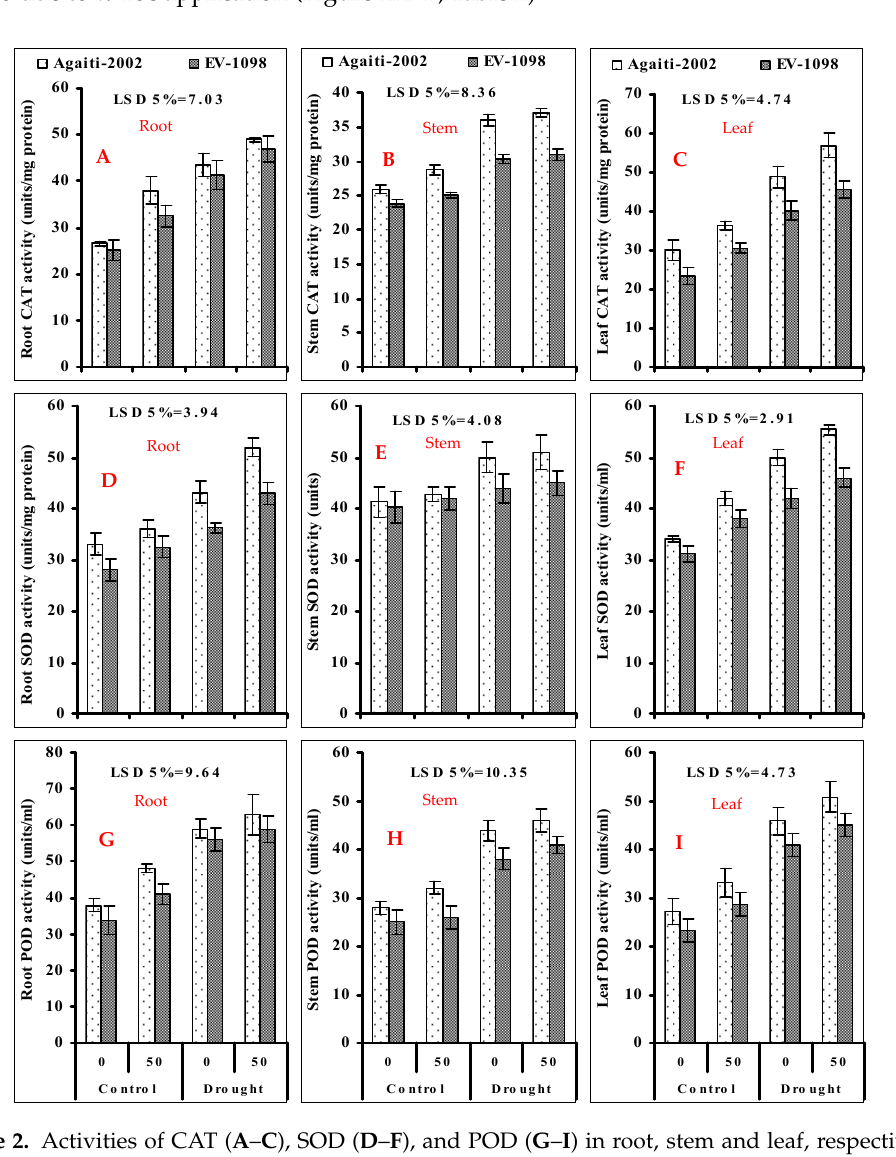
Figure 2. Activities of CAT ( A – C ), SOD ( D – F ), and POD ( G – I ) in root, stem and leaf, respectively, of drought ‐ stressed maize plants applied with α‐ Toc as foliar spray when grown under water deficit conditions (mean ± SE; n = 4). CAT = catalase; SOD = superoxide dismutase; POD = peroxidase 0 and 50 = mmol solution of α‐ Tocopherol for foliar spray.